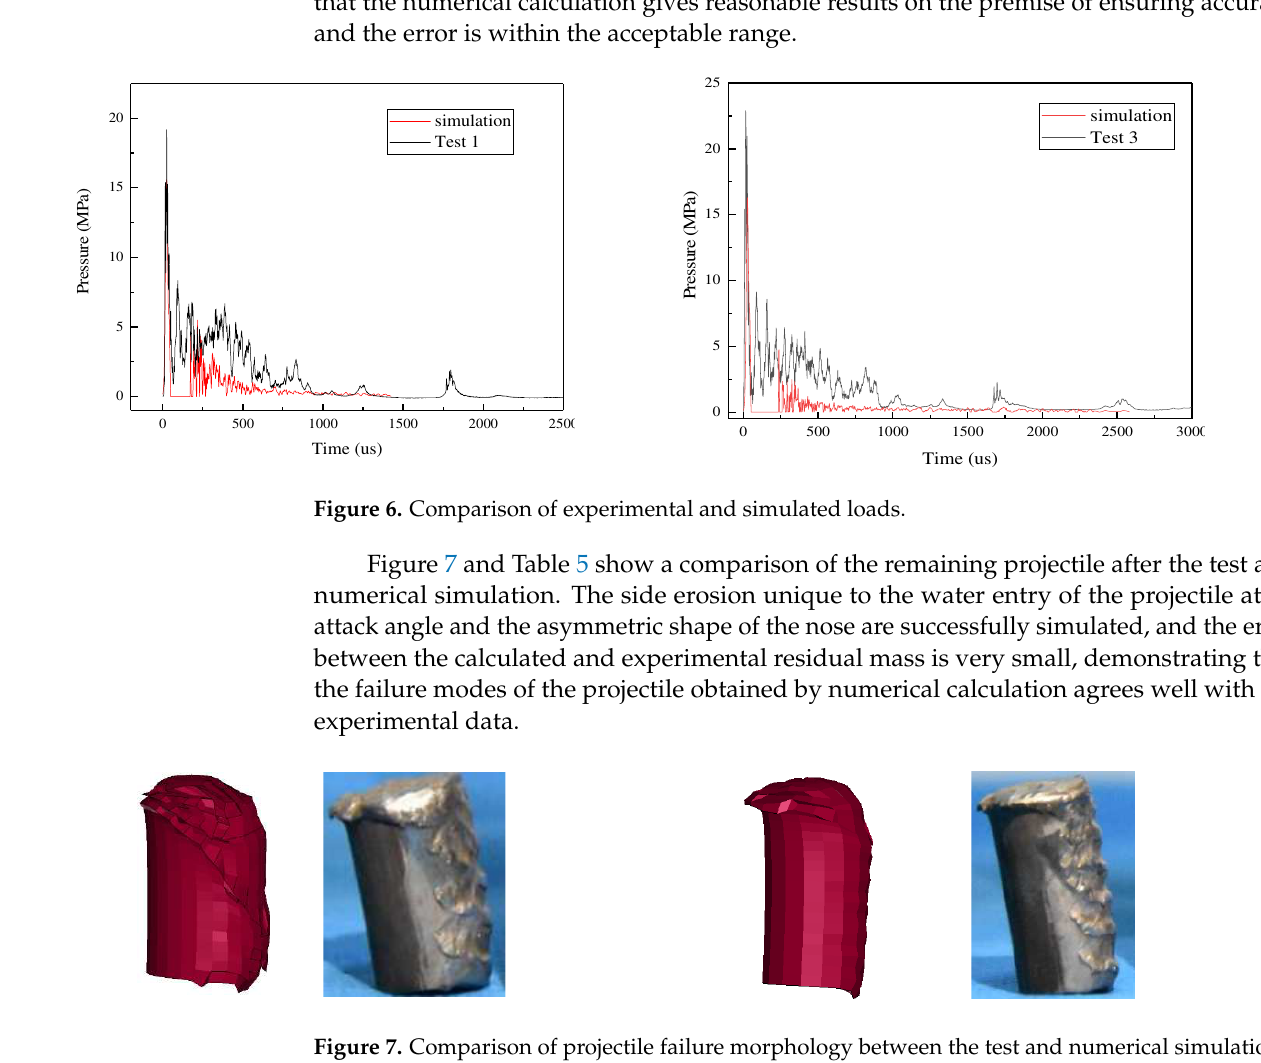
( b ) Figure 5. Comparison of tested and simulated velocities. ( a ) Test 1 velocity curve; ( b ) test 3 velocity curve.